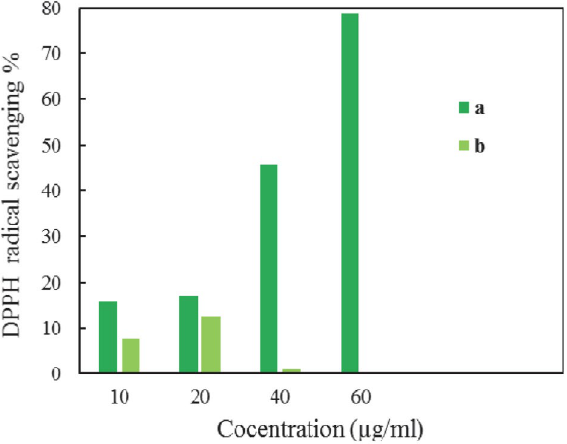
Fig. 1 . Effects of 1,2-[1-(3-imino-4-hydroxophenylazo-4-nitroben- zene)]-4-nitrobenzene ( a ) and 1,2-[1-(3-imino-4-hydroxophenyla- zobenzene)]-4-nitrobenzene ( b ) against DPPH after 10 min